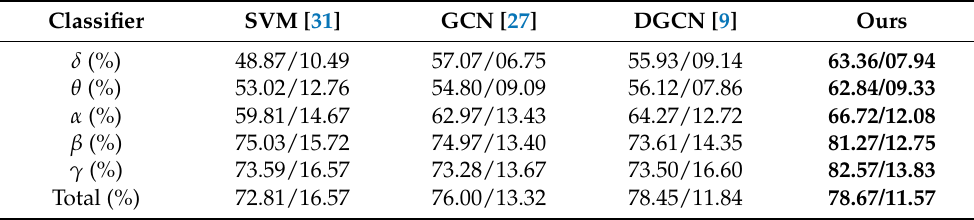
Table 2. The accuracy and standard deviation on SEED with DASM features. The best results are marked in bold.